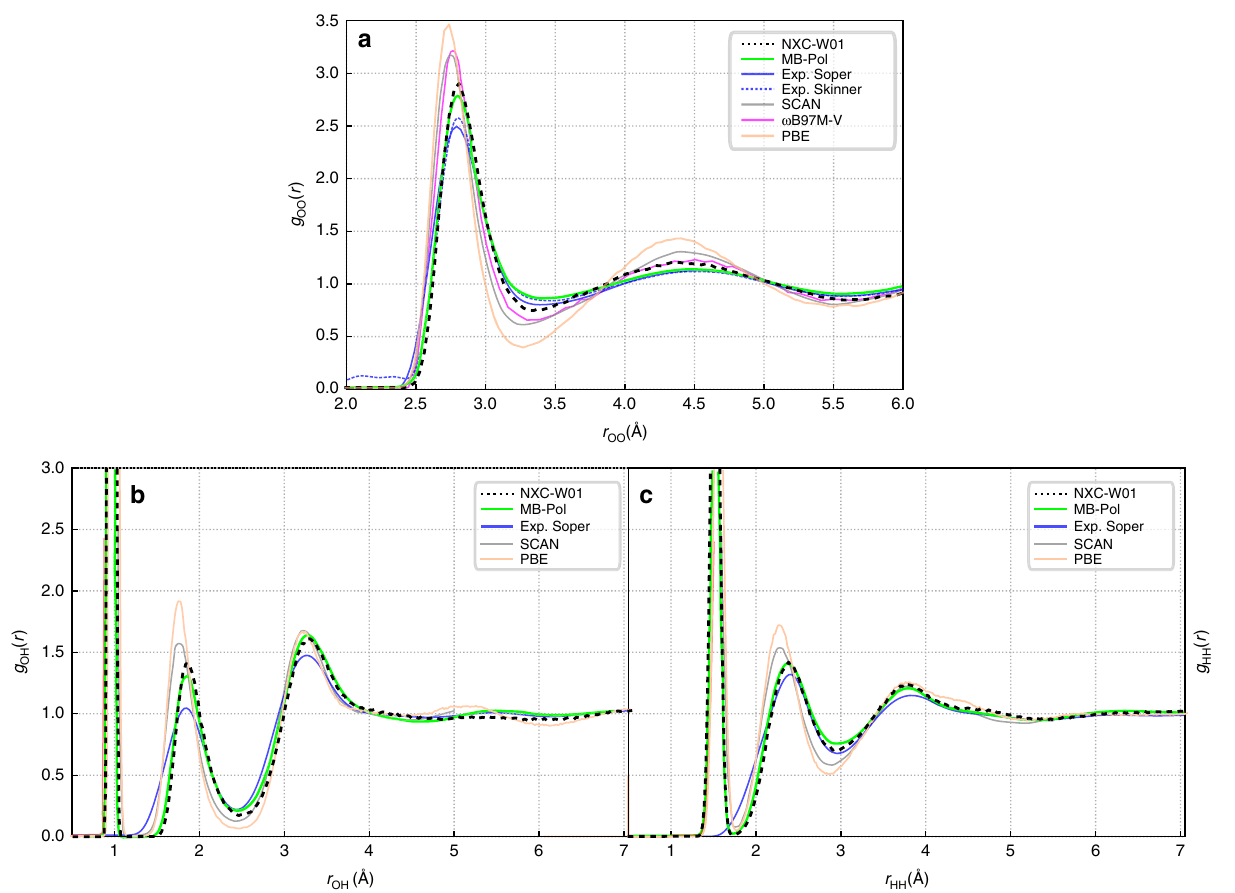
Fig. 5 Radial distribution functions (RDFs). a – c The RDFs obtained from Born – Oppenheimer molecular dynamics simulations of 96 water molecules in a periodic box at experimental density and 300 K using PBE and NXC-W01 as functionals are compared to experimental results by Skinner et al. 28 and Soper 29 as well as MB-Pol results taken from ref. 11 and Born – Oppenheimer MD simulations using SCAN by Wiktor et al. 30 and ω B97M-V by Yao et al. 31